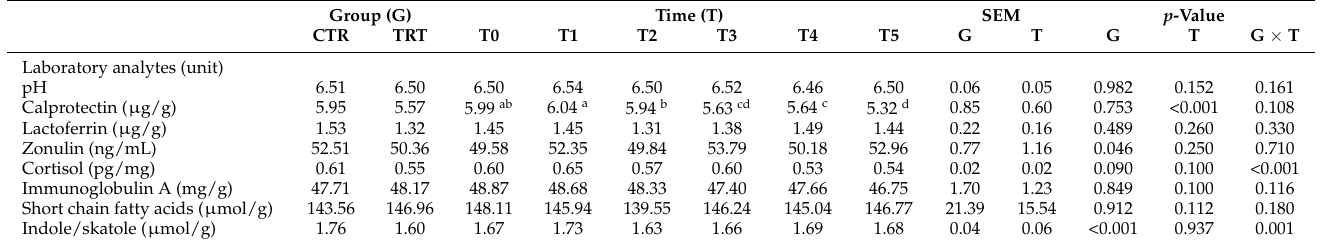
Table 1). Table 1. Nutritional parameters and laboratory analytes of the dogs depending on the group (G) they belong to (CRT = control; TRT = treated), time (T), and their interaction (G × T). Group (G)